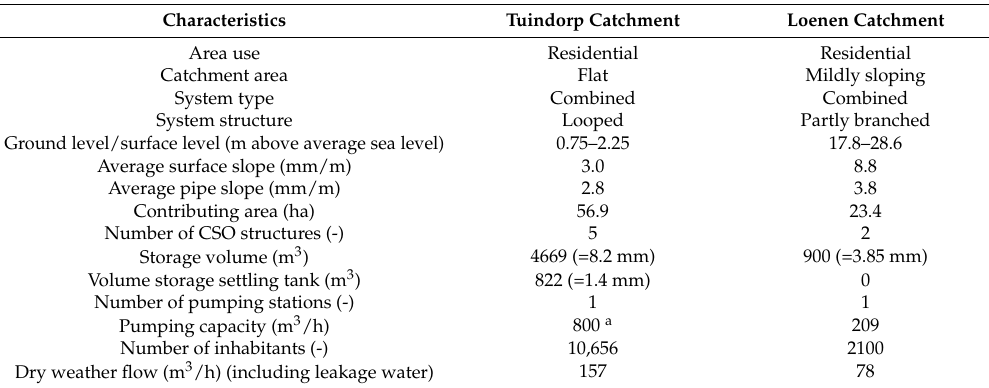
Figure 1. Procedure for calculating average catchment-wide infection probabilities. Table 1. Main characteristics of ‘Tuindorp’ and ‘Loenen’ catchments.